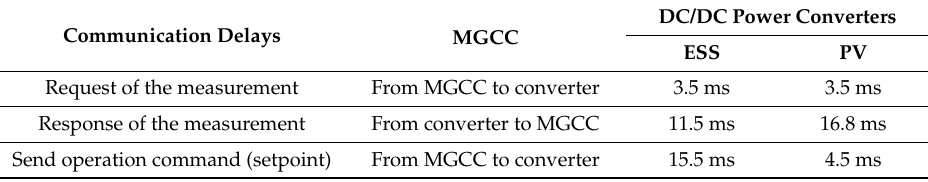
Table 5. Communication delays between the DC/DC power converters and the